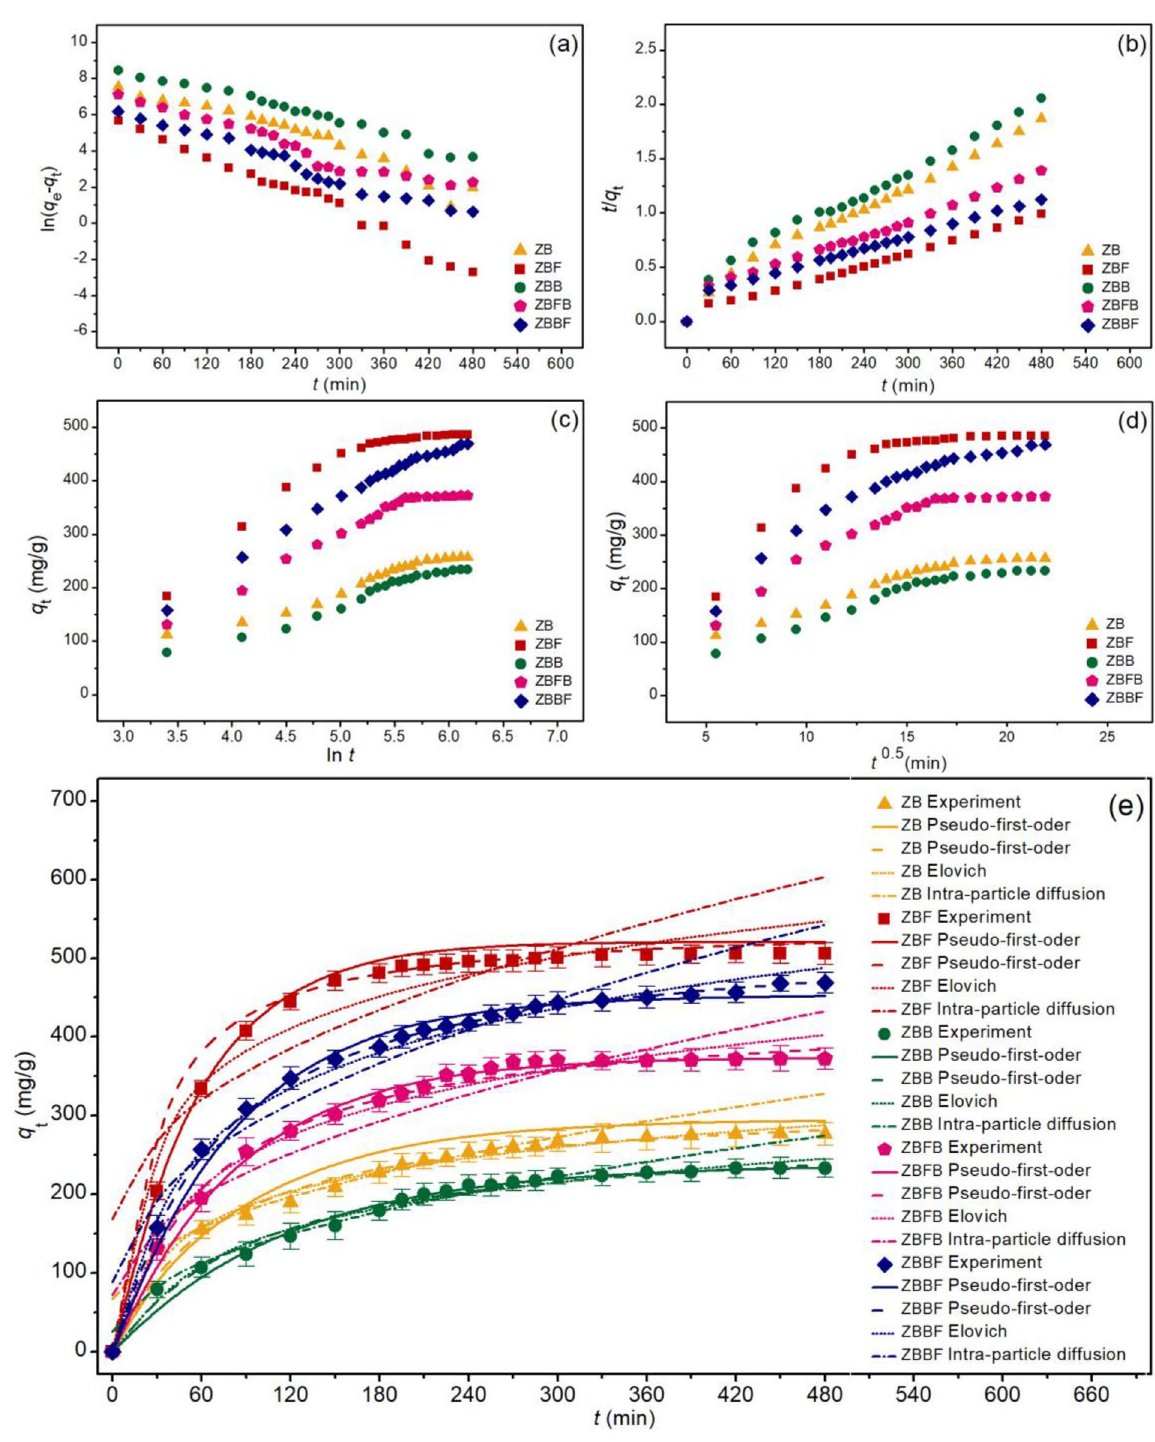
Figure 9. Graphs of ( a ) linear pseudo-first-order, ( b ) linear pseudo-second-order, ( c ) linear elovich model ( d ) linear intra-particle diffusion, and ( e ) nonlinear kinetic models of zeolite A sugarcane bagasse fly ash powder (ZB), zeolite A sugarcane bagasse fly ash powder mixed iron(III) oxide- hydroxide (ZBF), zeolite A sugarcane bagasse fly ash beads (ZBB), zeolite A sugarcane bagasse fly ash powder mixed iron(III) oxide-hydroxide beads (ZBFB), and zeolite A sugarcane bagasse fly ash beads coated iron(III) oxide-hydroxide (ZBBF) for lead